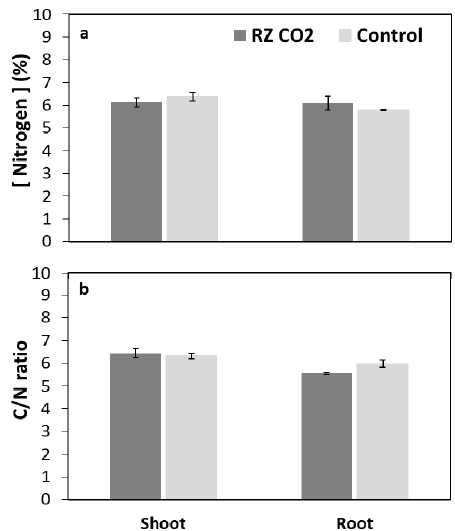
Figure 5. Shoot and root N concentration ( a ) and C/N ratio ( b ) in pepper plants exposed to high and ambient RZ CO 2 . Experiment 10. Bars represent the means ± SE of eight replicates. Asterisks indicate significant differences between treatments (Independent Sample T-test, p -value < 0.05).